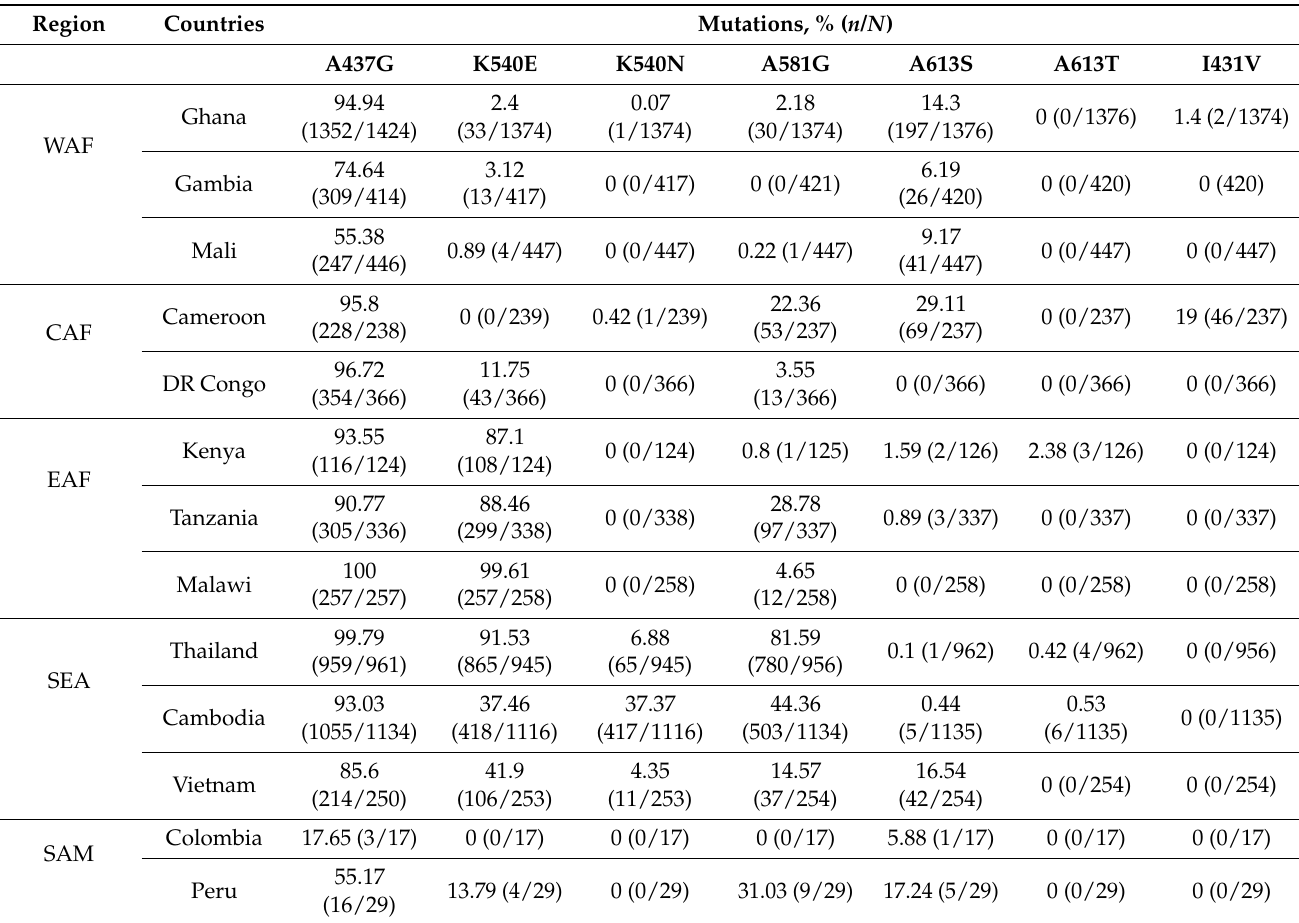
Table 1. Global prevalence of missense mutations detected on Pf